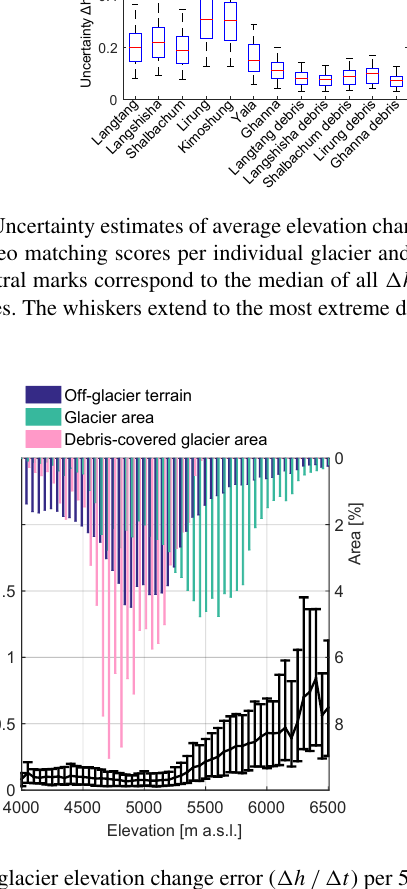
Figure 3. Off-glacier elevation change error ( (cid:49)h/(cid:49)t ) per 50m el- evation band. The black line represents the median error in the en- semble of six (cid:49)h/(cid:49)t maps. Error bars represent 95% confidence intervals. The color bars represent hypsometries of glacier area, off- glacier area and debris-covered glacier areas,